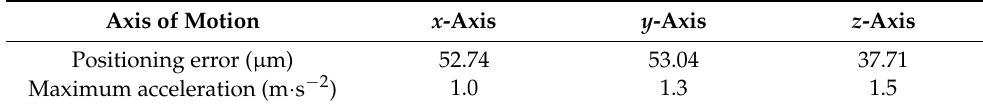
Table 1. Dynamic and static performance measurement results of IBF700.